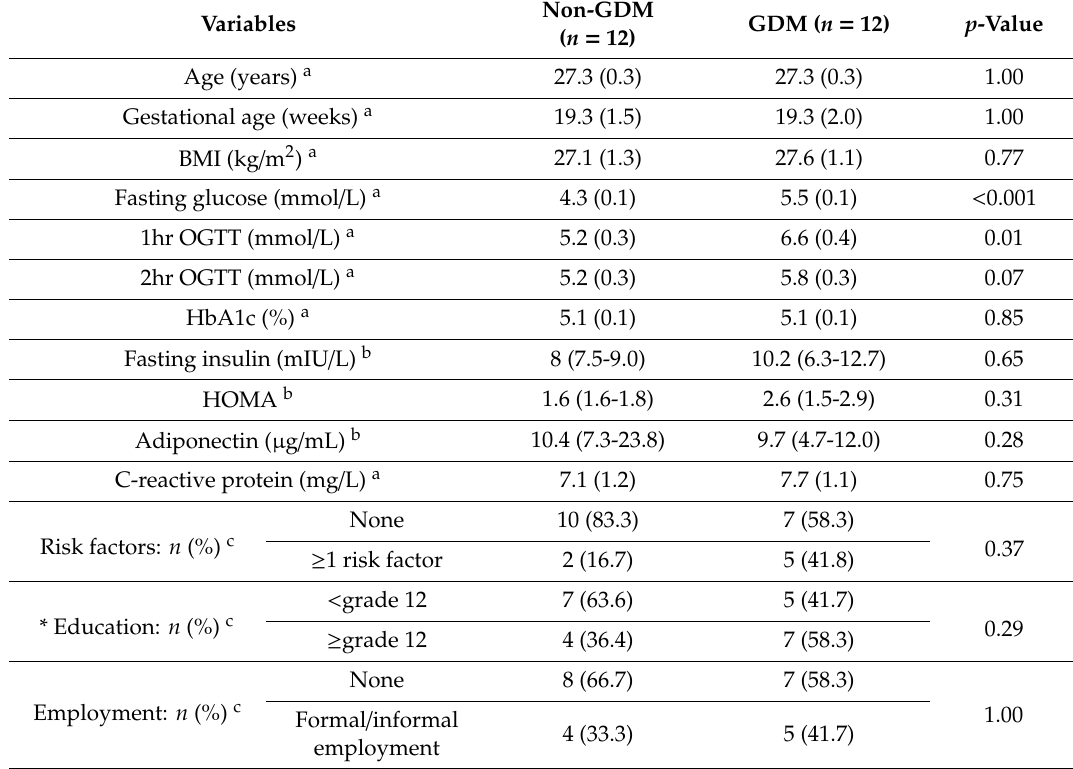
Table 1. Participant